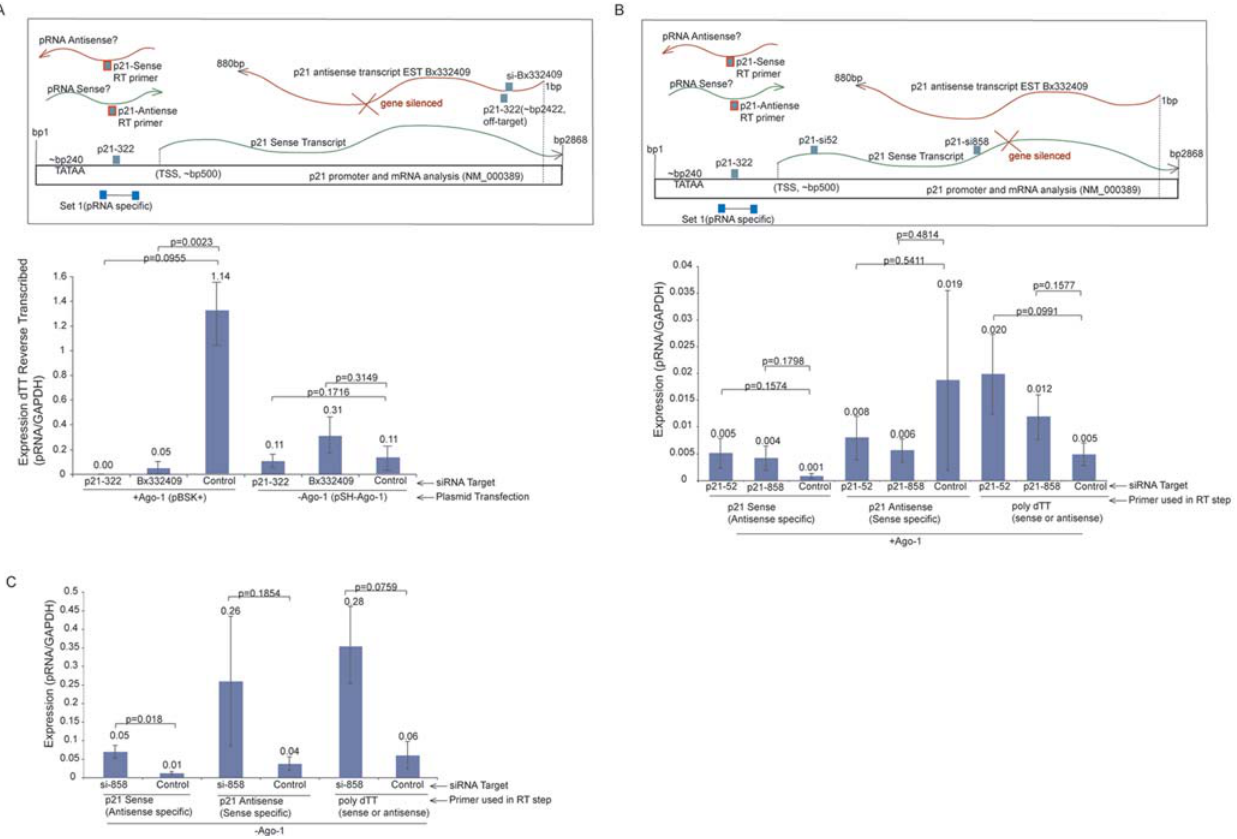
Figure 4. Both the p21 antisense transcript and Ago-1 are required for the regulation of p21 promoter-associated RNAs and the suppression of promoter activity. (A) The antisense transcript, Bx332409, was silenced post-transcriptionally (shown in inset) with p21-322 or si- Bx332409 siRNAs (50 nM) in the presence or absence of Ago-1. In the absence of Ago-1, an enrichment of dTT reverse transcribed p21 promoter associated RNAs (pRNA) are observed. Averages from triplicate transfected cultures, standard deviations, and p values from paired T tests are shown. (B and C) The p21 sense transcript, coding mRNA, was silenced post-transcriptionally (shown in inset) with p21-52 or p21-858 siRNAs (50 nM) in the presence (B) or absence (C) of Ago-1. In the presence of Ago-1 and p21 antisense transcription (B) an increase in p21 antisense pRNAs are observed with a concomitant loss of p21 sense pRNAs. In the absence of Ago-1 however (C) a loss of antisense pRNAs and an enrichment for sense transcribed p21 pRNAs is observed. Averages, standard deviations, and p values from paired T tests are shown from triplicate transfected